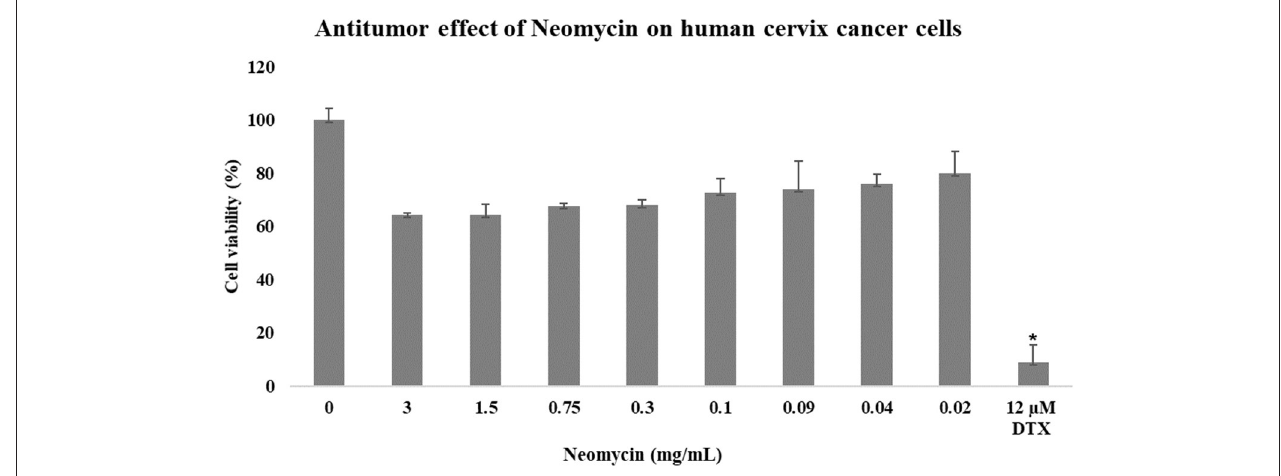
FIGURE 3 | Antitumor effect of neomycin on HeLa cells. Cell viability was evaluated with the MTT cell viability assay after a 24-h exposure to 0, 3, 1.5, 0.75, 0.3, 0.1, 0.09, 0.04, and 0.02 of neomycin and 12 µ M docetaxel (DTX) as positive control of cytotoxicity. Asterisks indicate statistical differences ( p < 0.0001) ( α = 0.05).